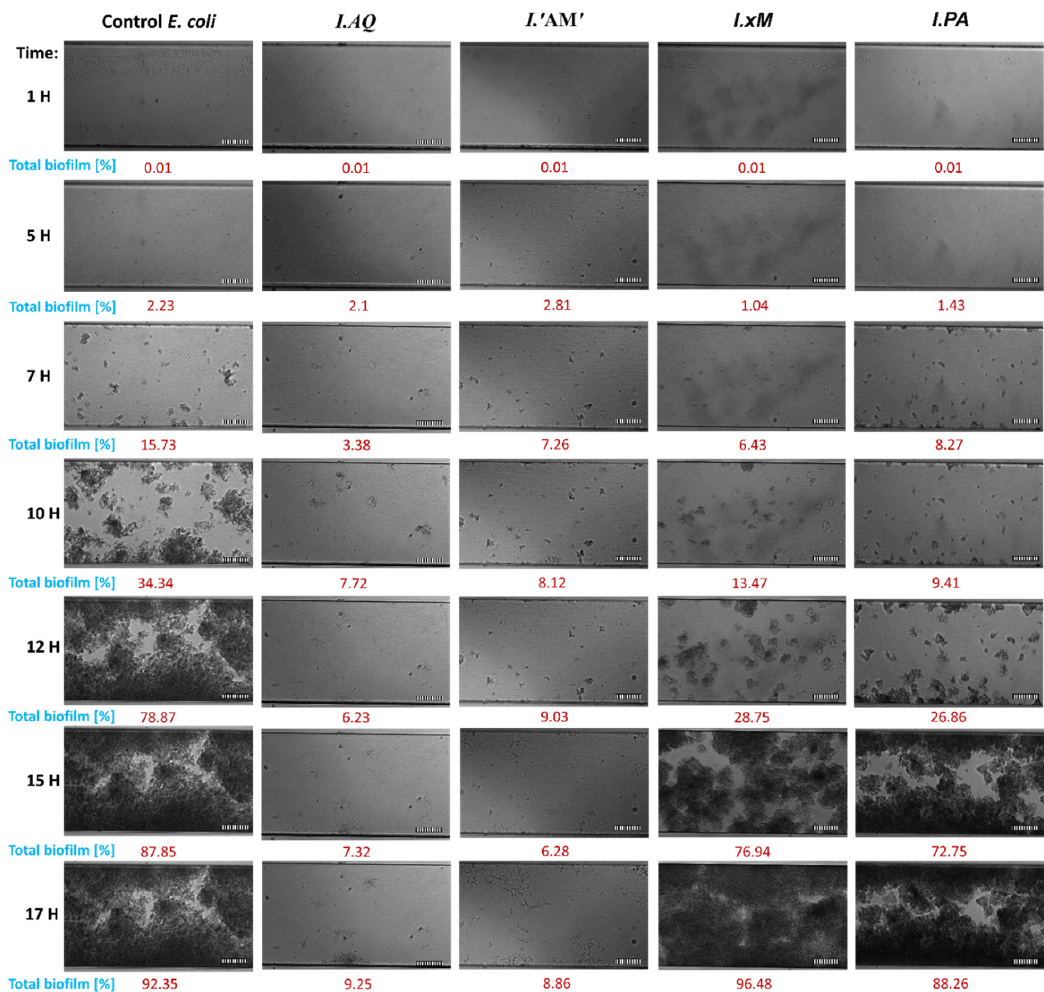
Figure 2. Imaging of the channel cross section with E . coli biofilms during 17 h of incubation at flow conditions (0.5 dyn cm 2 ). Biofilms were formed by bacteria treated with Ilex spp. water extracts (1/2 MIC). Biofilms were visualised using differential interference contrast (DIC); Control—untreated bacteria; scale bar = 100 µm. Legend: I.PA — I. paraguariensis ;